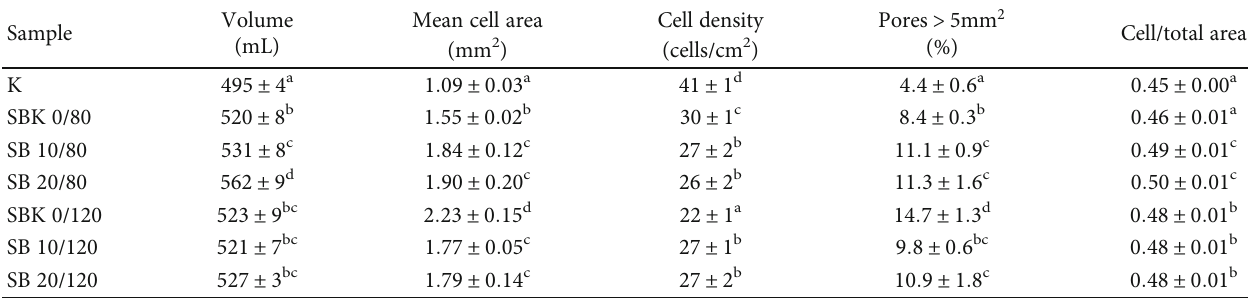
Table 5: Volume and image analysis parameters of analyzed bread